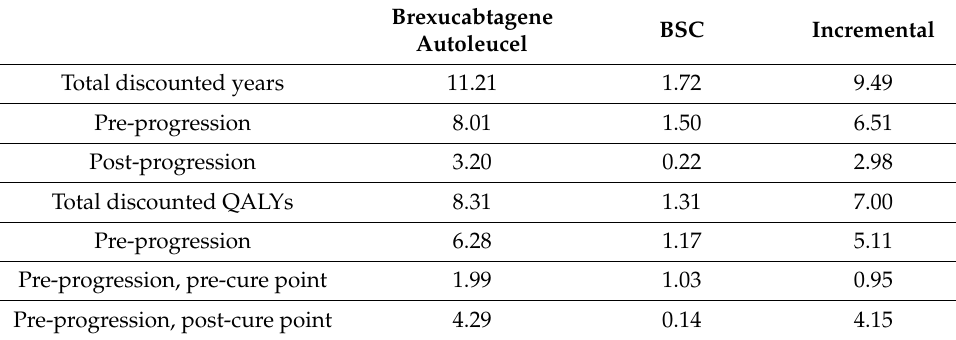
Table A7. Disaggregated cost and outcomes of brexucabtagene autoleucel vs. BSC based on 1000